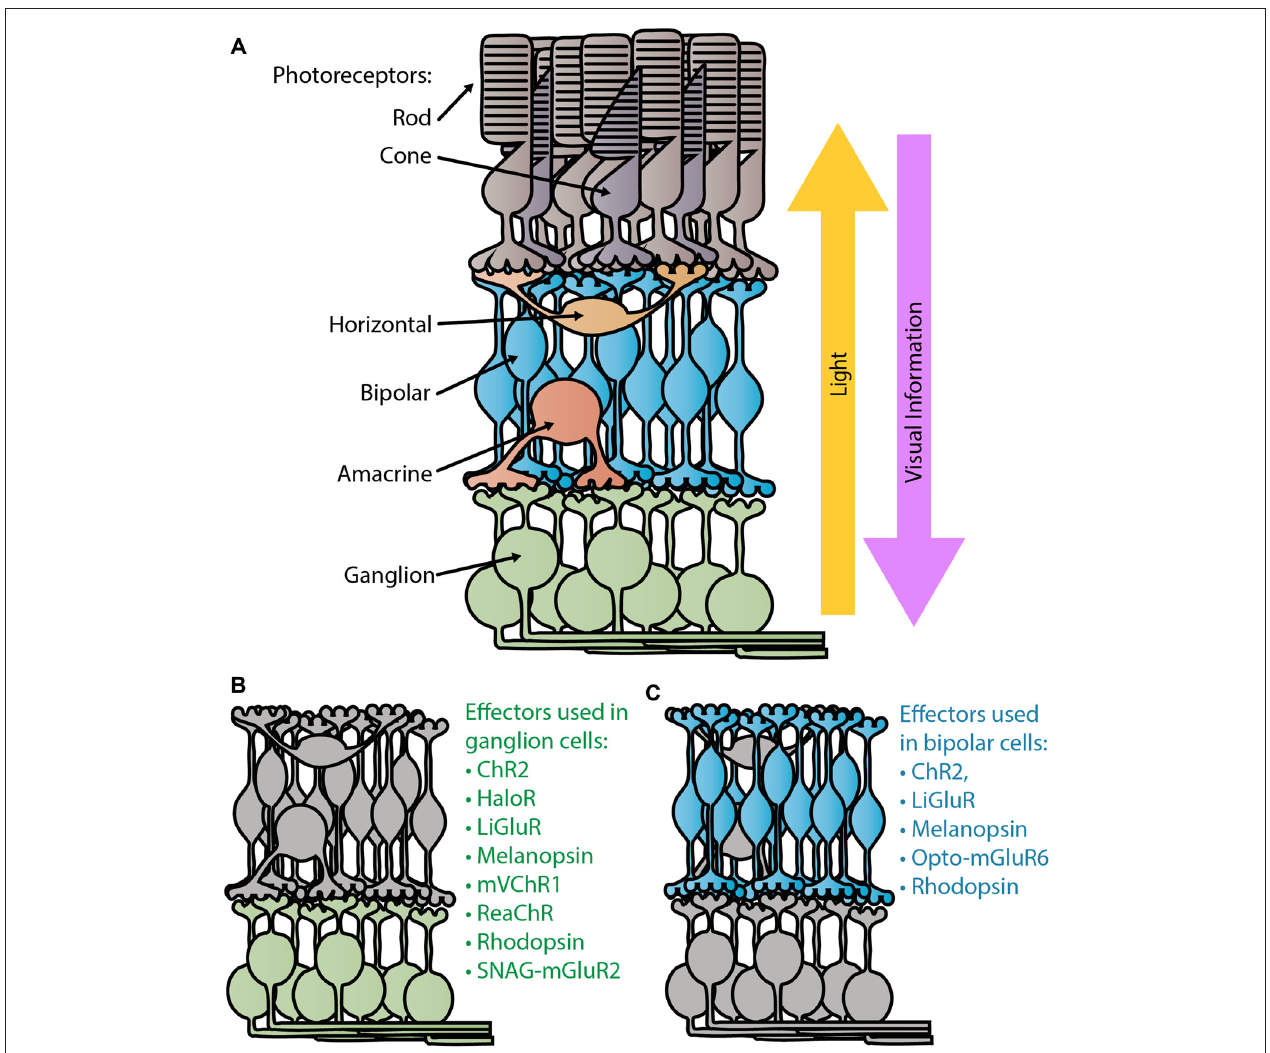
FIGURE 1 | Retina schematic. (A) Diagram of a normal healthy retina. Light passes through the retina, entering through the retinal ganglion cell (RGC) layer to reach the light sensitive photoreceptors, the rods and cones, in the outer retina. Visual information is sent from the photoreceptors to the bipolar cells where the ON/OFF processing begins. Ganglion cells are the terminal retinal signal recipients and they relay onto neurons in the lateral geniculate nucleus in the thalamus. Panels (B,C) depict the degenerate retina without photoreceptors. Panel (B) lists the optogenetic therapies that have been tested in ganglion cells (Bi et al., 2006; Lin et al.,